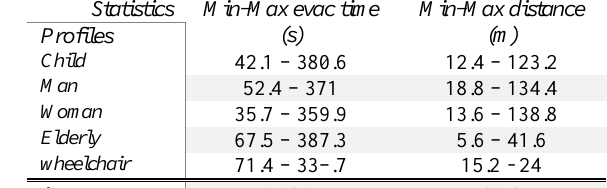
Table 3. A sample of selected individuals to investigate the effect of combustion effects on their health.